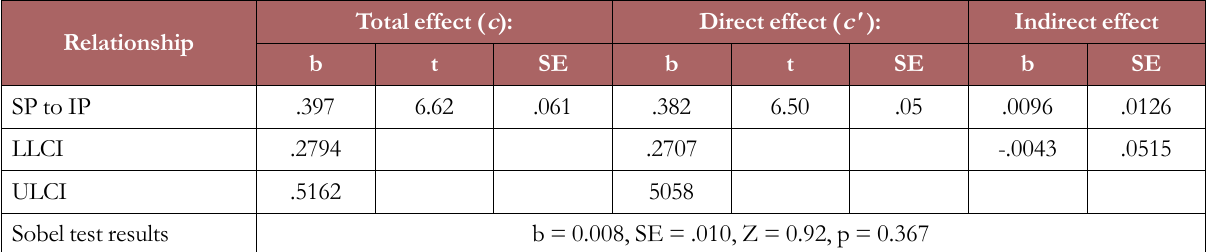
Sobel test results